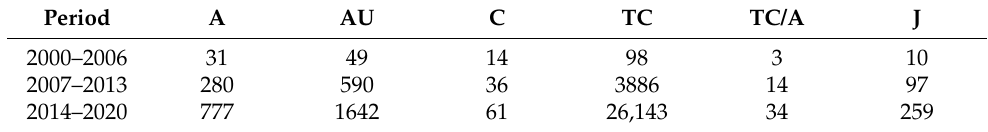
Table 1. Major characteristics of PSS from 2000 to